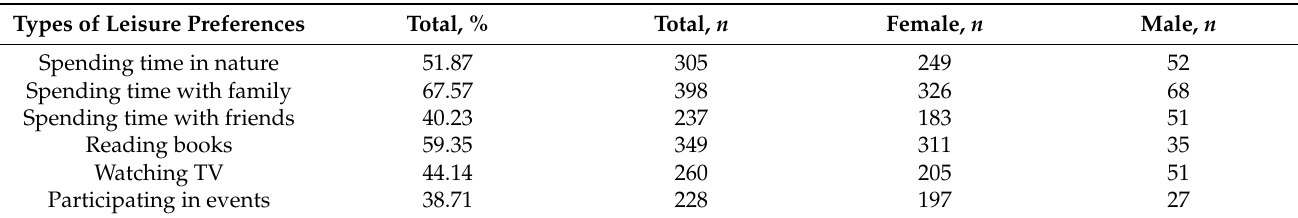
Table 3. Frequencies of leisure preferences.